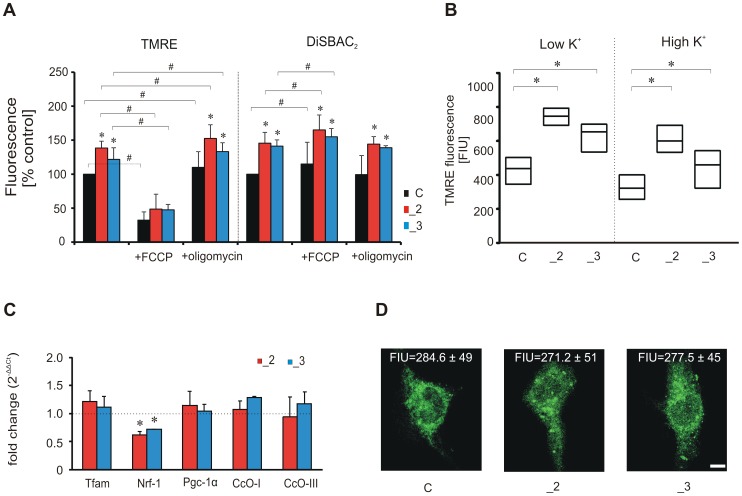
The relative contribution of ΔΨm and ΔΨp to TMRE fluorescence.(A) The effect of 10 min preincubation with FCCP (1 µM) or oligomycin (6 µM) on TMRE or DiSBAC2 fluorescence assessed by flow cytometry in 104 cells. The fluorescence level in non-treated cells was taken as 100%. * P<0.05, PMCA-deficient lines vs. control cells within inhibitor treated or non-treated groups; # P<0.05, inhibitor treated cells vs. non-treated. (B) The dependence of increased TMRE on ΔΨp. Before experiment, the medium was exchanged for Ca2+-free buffer (20 mM HEPES, pH 7.4, 2 mM CaCl2, 150 mM NaCl, 5 mM KCl, 1 mM MgCl2, 10 mM glucose) containing either 5 mM (low K+) or 59 mM (high K+) KCl, in which cells were incubated for 5 min before the addition of TMRE. After 10 min loading period, cellular TMRE fluorescence was acquired. Data are presented in median/quartiles and represent average values from 104 cells. *P<0.05, PMCA-deficient cells vs. control. (C) Real-time PCR analysis of mitochondrial biogenesis markers (Tfam, Nrf-1 and Pgc-1α) and mitochondrially encoded subunits I and III of cytochrome c oxidase (CcO). The expression level of each gene in control line was taken as 1 (dotted line). The relative fold change after normalization to Gapdh expression is shown. * P<0.05, PMCA-deficient lines vs. control cells. (D) Evaluation of mitochondrial mass with MitoTracker Green TM in fixed cells using TCS S5 confocal microscope. The average fluorescence from n = 9, n = 11, n = 14 cells for C, _2, _3 lines, respectively, was measured with microscope accompanying software. Scale bar 10 µm. FIU – fluorescence intensity units.